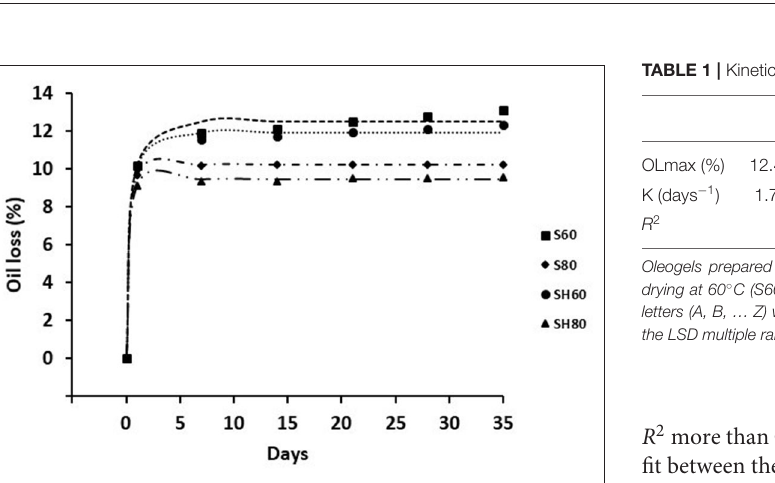
FIGURE 2 | Oil loss curves for oleogels prepared with sunflower (S) and high oleic sunflower oil (SH), and developed by conventional drying at 60 ◦ C (S60, SH60) and 80 ◦ C (S80, SH80).